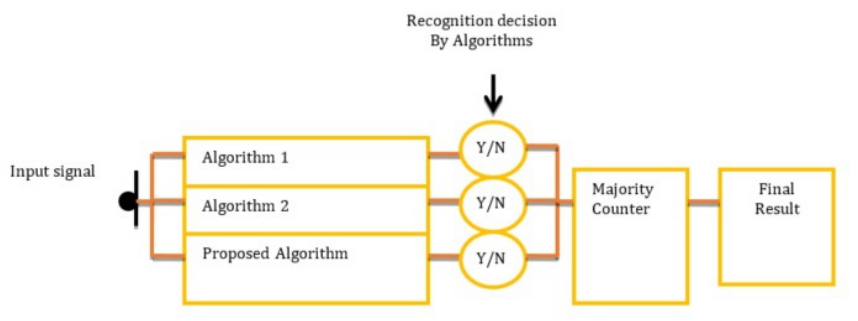
Figure 25. Flow chart of the combined